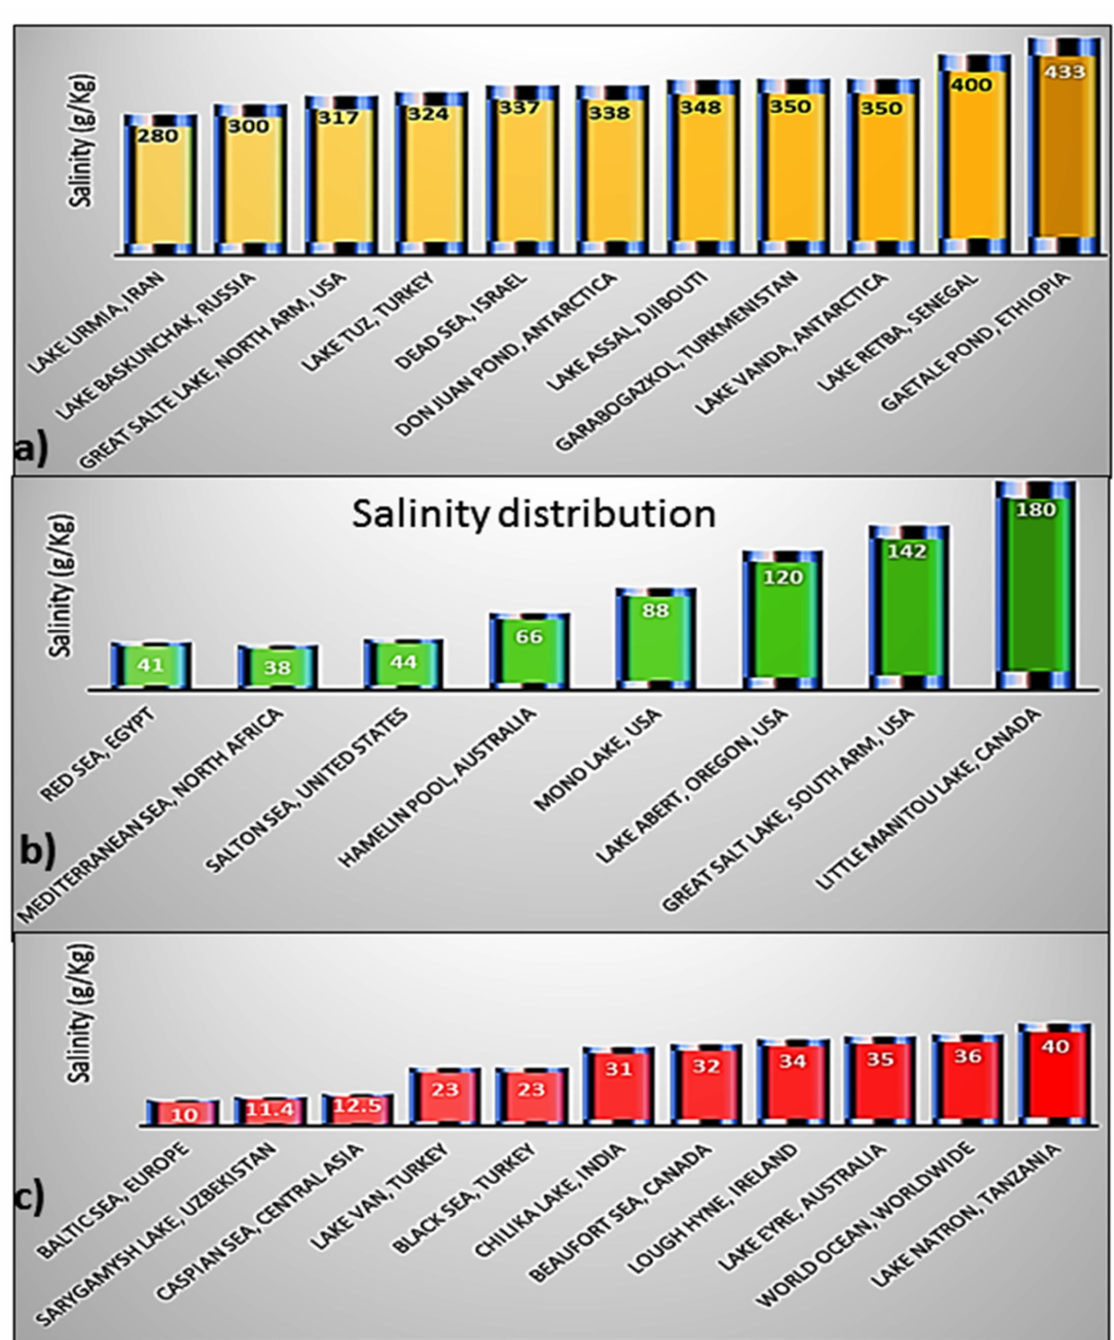
Figure 1. Distribution of various salinity regimes in different water bodies across the globe: Salinity (ppt) distribution in the ranges. ( a ) Salinity distribution in the range from 180 to 433 ppt, ( b ) Salinity distribution in the range from 38 to 142 ppt and ( c ) Salinity distribution in the range from 10–36